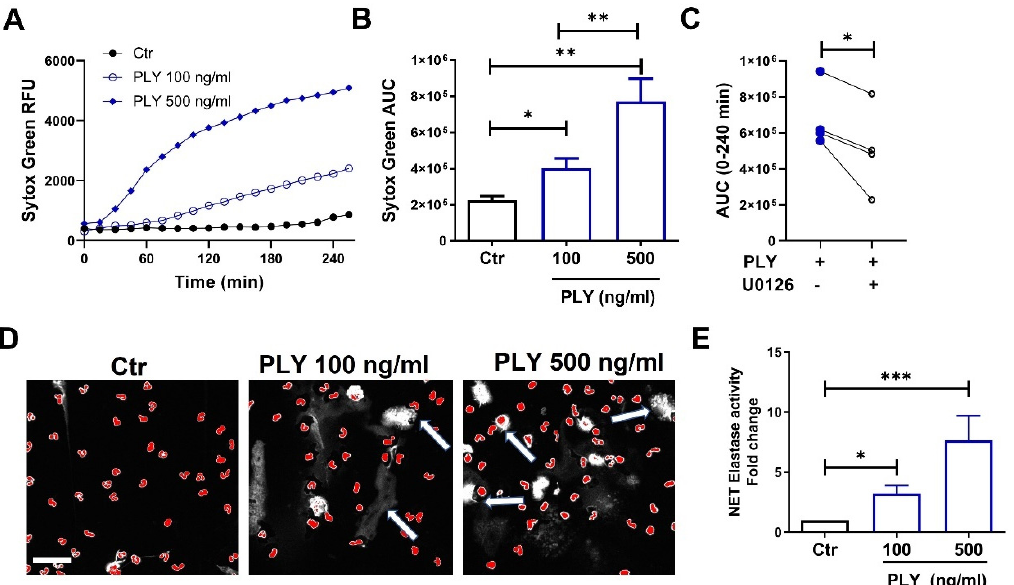
Figure 2. Pneumolysin triggers the formation of neutrophil extracellular traps (NETs). ( A , B ) NET formation was quantified using the cell-impermeant nucleic acid dye, SYTOX Green, in human neutrophils treated with PLY (100 or 500 ng/mL). ( A ) NET production (SYTOX Green fluorescence) was monitored over a period of 4 h (representative graph), ( B ) Bars represent the area under the curve (AUC) of Sytox Green fluorescence for Ctr and PLY-treated cells calculated from the kinetic curves. n = 12, * p < 0.05, ** p < 0.01, one-way ANOVA. ( C ) NET production in neutrophils pre-treated with U0126 (25 μ M) and then challenged with PLY (100 ng/mL). AUC for each condition was calculated from the kinetic curves (Sytox Green assay). Each line represents neutrophils from the same donor differentially treated. n = 4. * p < 0.05, paired t -test. ( D ) Neutrophils were treated with PLY, fixed, and stained with the nuclear stain DAPI. Depicted are representative pseudocolor images. Red represents intact nuclei. White staining indicates extracellular DNA. Arrows indicate extracellular DNA structures. Pictures were taken at 40x magnification. Scale bar: 50 μ m. n = 3. ( E ) Elastase activity was measured in isolated NETs from PLY-treated or control neutrophils. n = 7–9. * p < 0.05, *** p < 0.001, one-way ANOVA.